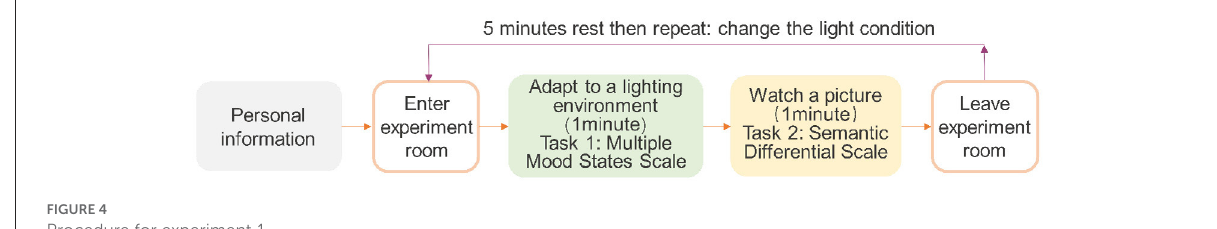
FIGURE4 Procedure for experiment 1.